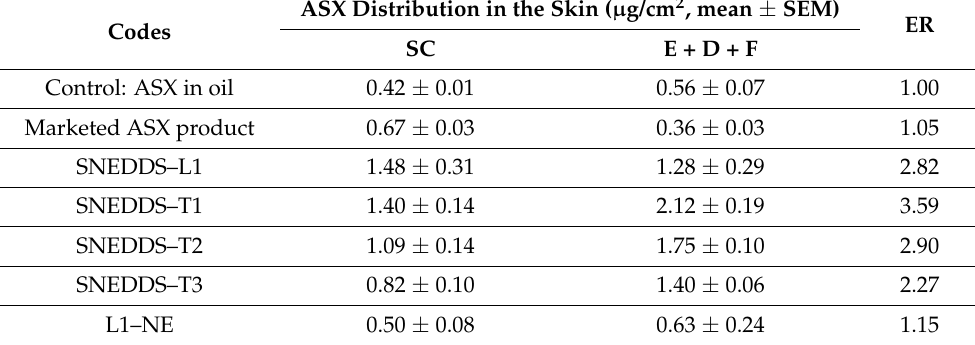
Table 4. Skin distribution of ASX from SNEDDS formulations, marketed product, and oil solution control (mean ± SEM; n =